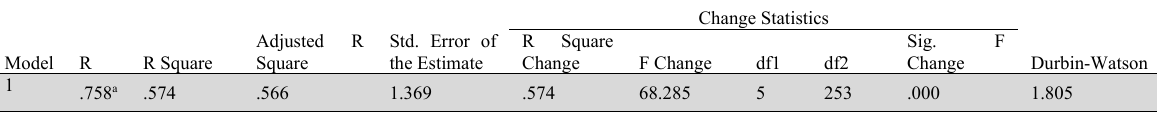
The summary of the regression analysis